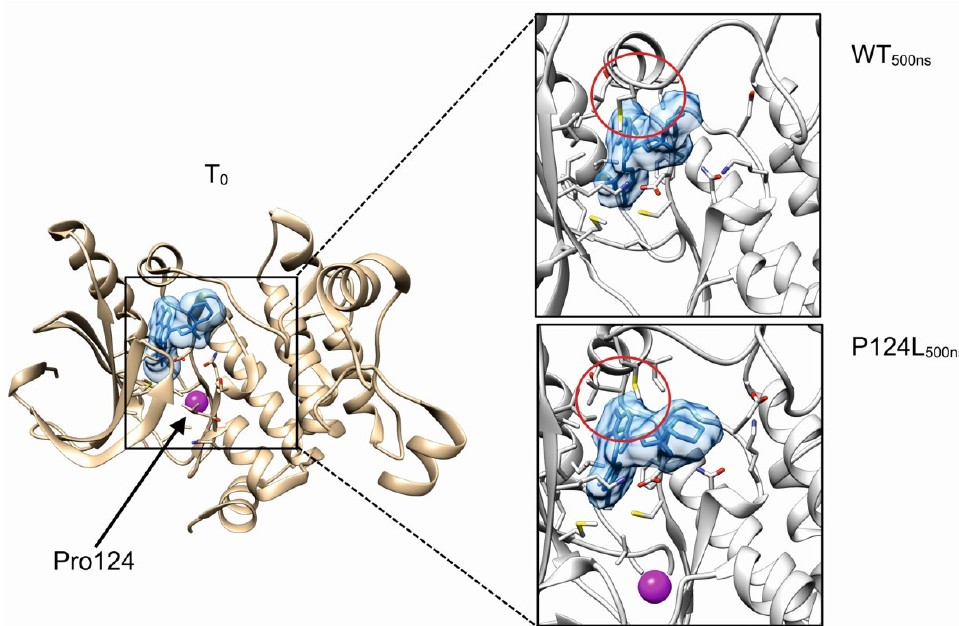
Figure 1. In silico investigation of MEK1 p.P124L mutant. Boxes show the final system states after 500 ns of molecular dynamics simulations. Cobimetinib is represented with solid blue, while purple represents the position of proline 124 residue. Red circle highlights the kinase activation loop. MEK1 residues relevant for the interaction with cobimetinib are represented with sticks.